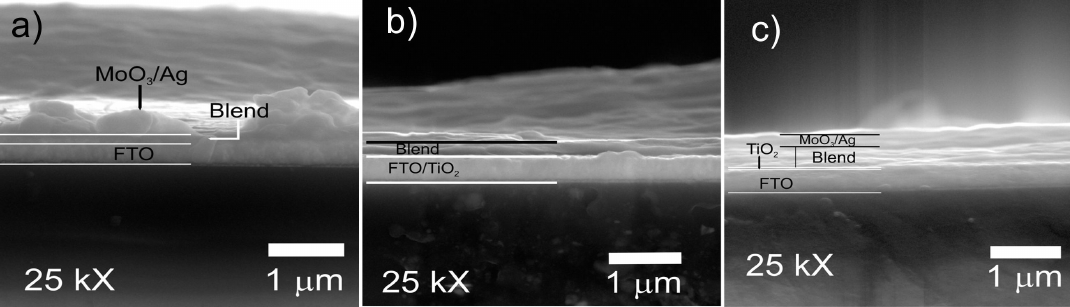
/P3HT:PC BM/MoO /Ag 2 61 3